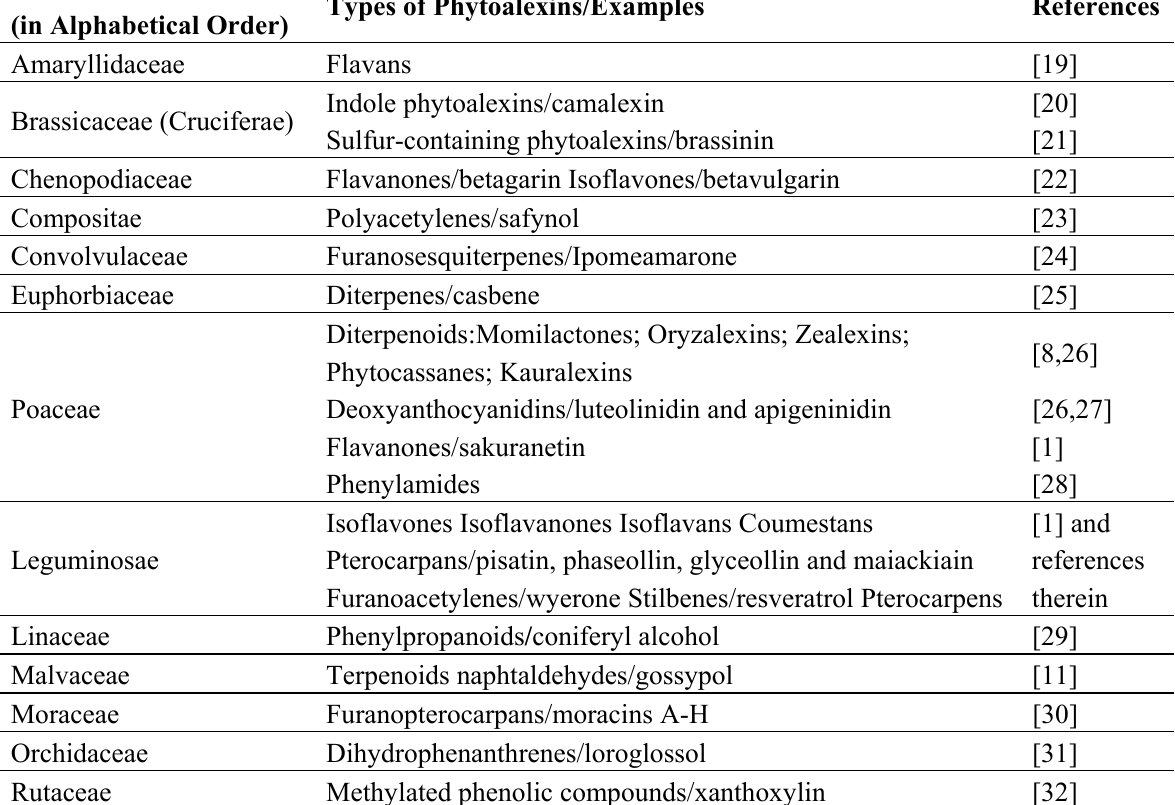
Table 1. Phytoalexins from different plant